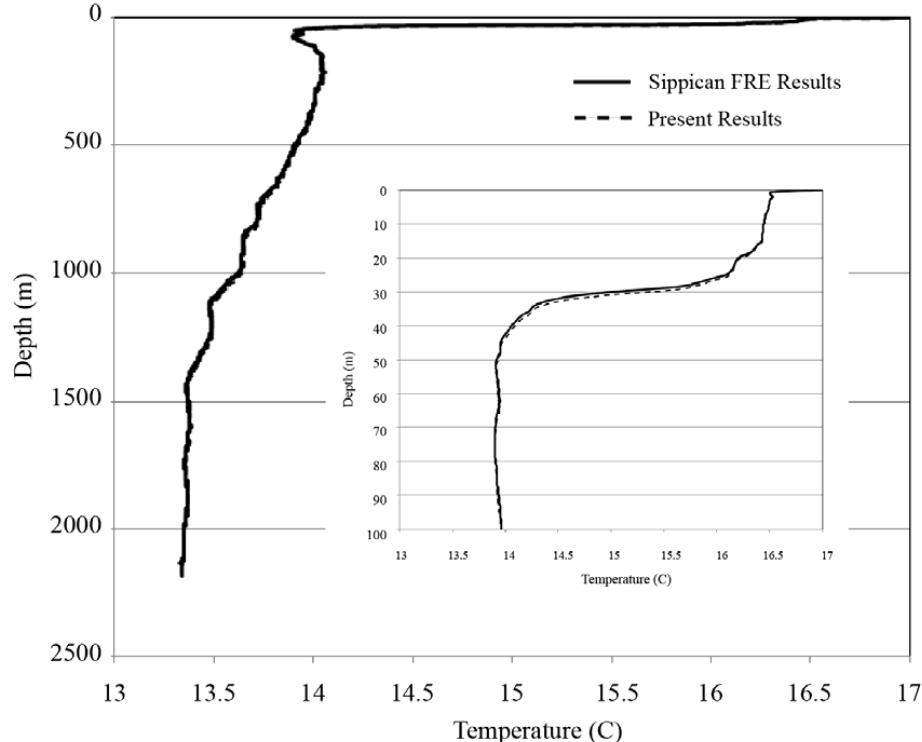
Fig. 7. Comparison of present depth-temperature results with current manufacturer Fig. 7 – Comparison of present depth-temperature results with current manufacturer FRE.